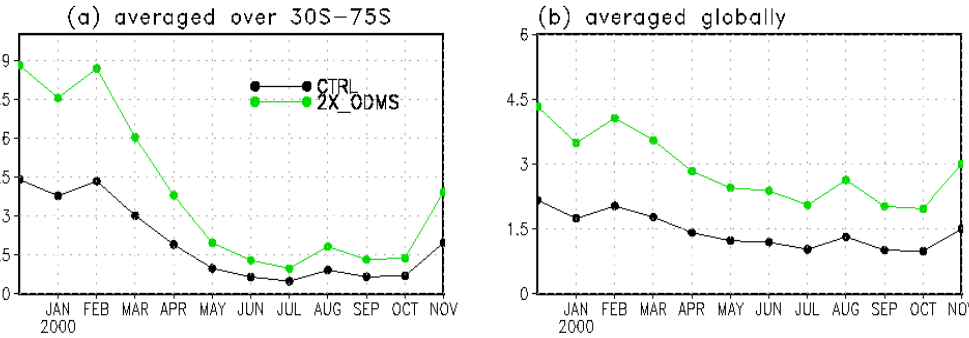
Fig. 1. Time series of ocean DMS emissions in Kg(S)m − 2 s − 1 in the 2X ODMS (open circled line) and CTRL (plain line) simulations (a) averaged over 30 ◦ S–75 ◦ S and (b) averaged globally. The emissions are multiplied by 10 12 . Table 1. Percentage mean (DJF mean) change in DIAG1, DIAG2 and DIAG3 for (a) SO 2 column burden (b) H 2 SO 4 column burden (c) vertically integrated number of activated particles (Num act) and (d) aerosol optical depth (AOD) at 0.55µm averaged over 30 ◦ S– 75 ◦